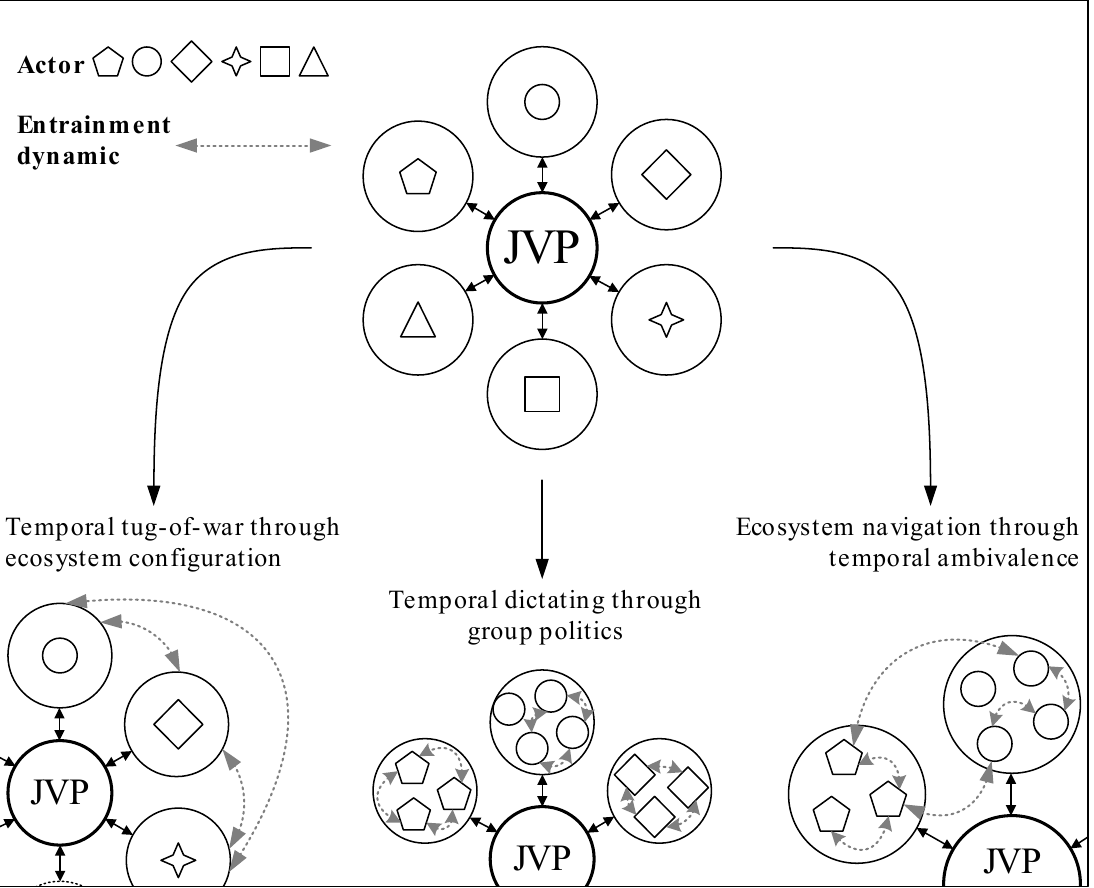
Figure 1. Overview of the innovation ecosystem setting and the three different entrainment dynamics. Table 1. Overview of the public charging ecosystem’s actors.